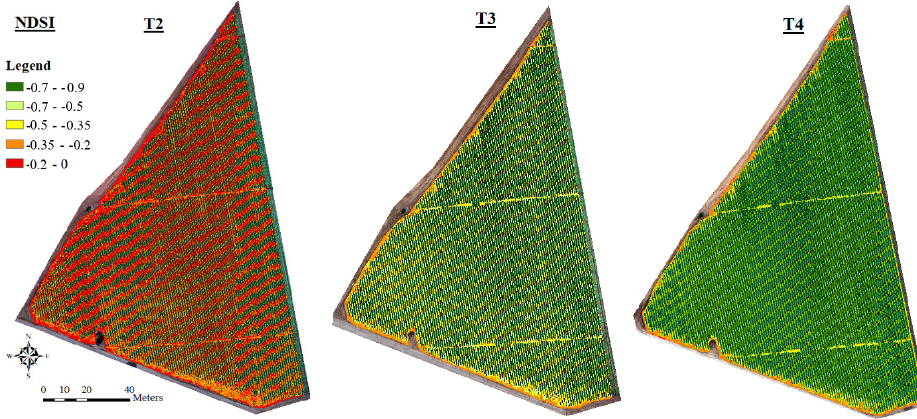
Figure 11. Map of the NDSI applied to bare soil for T2, T3, and